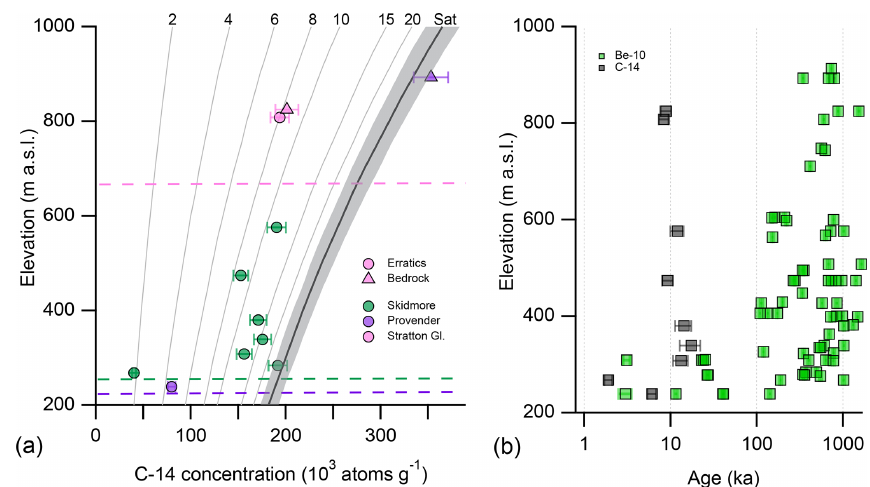
Figure 5. (a) Elevation versus in situ 14 C concentration of samples from the Shackleton Range. Circles are erratic cobbles; triangles are bedrock. Some error bars are smaller than their respective data points. Horizontal dashed lines show the approximate elevation of the modern ice surface at each site. Light grey lines indicate isochrons of exposure duration. Thick black line and grey shading are the saturation concentration and associated error envelope. (b) Exposure ages from this study (in situ 14 C) and 10 Be ages of Hein et al. (2011, 2014). Samples yielding infinite in situ 14 C ages are not presented on the right-hand plot.